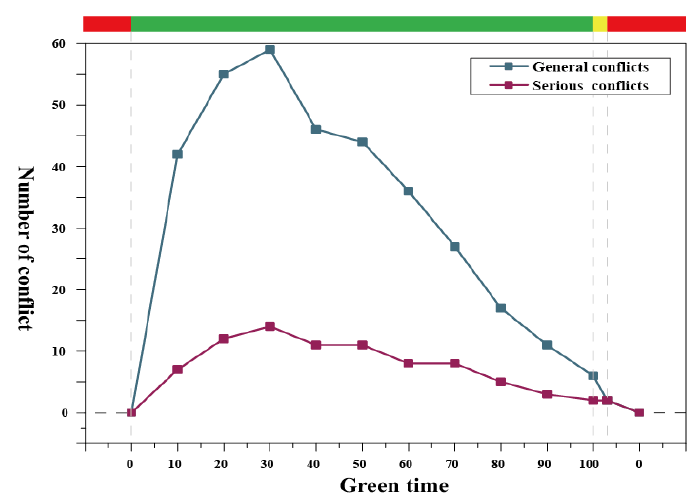
Figure 13. Overall conflicts distribution of Type 1.